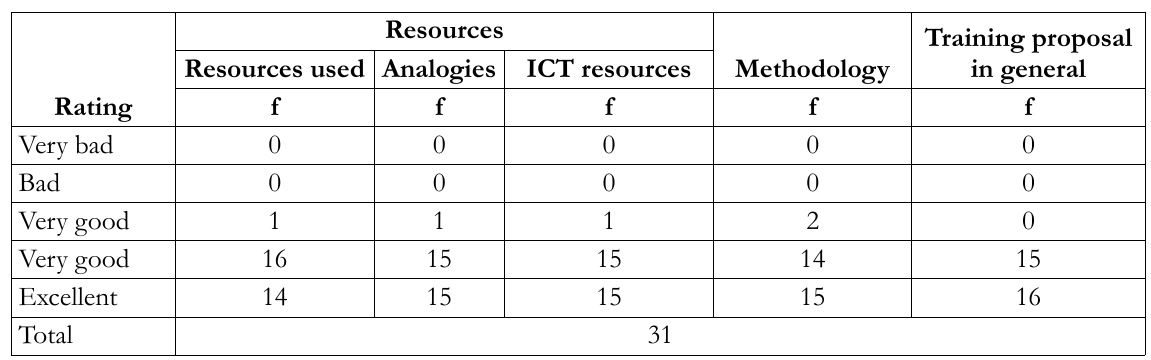
Table 12. Assessments by the